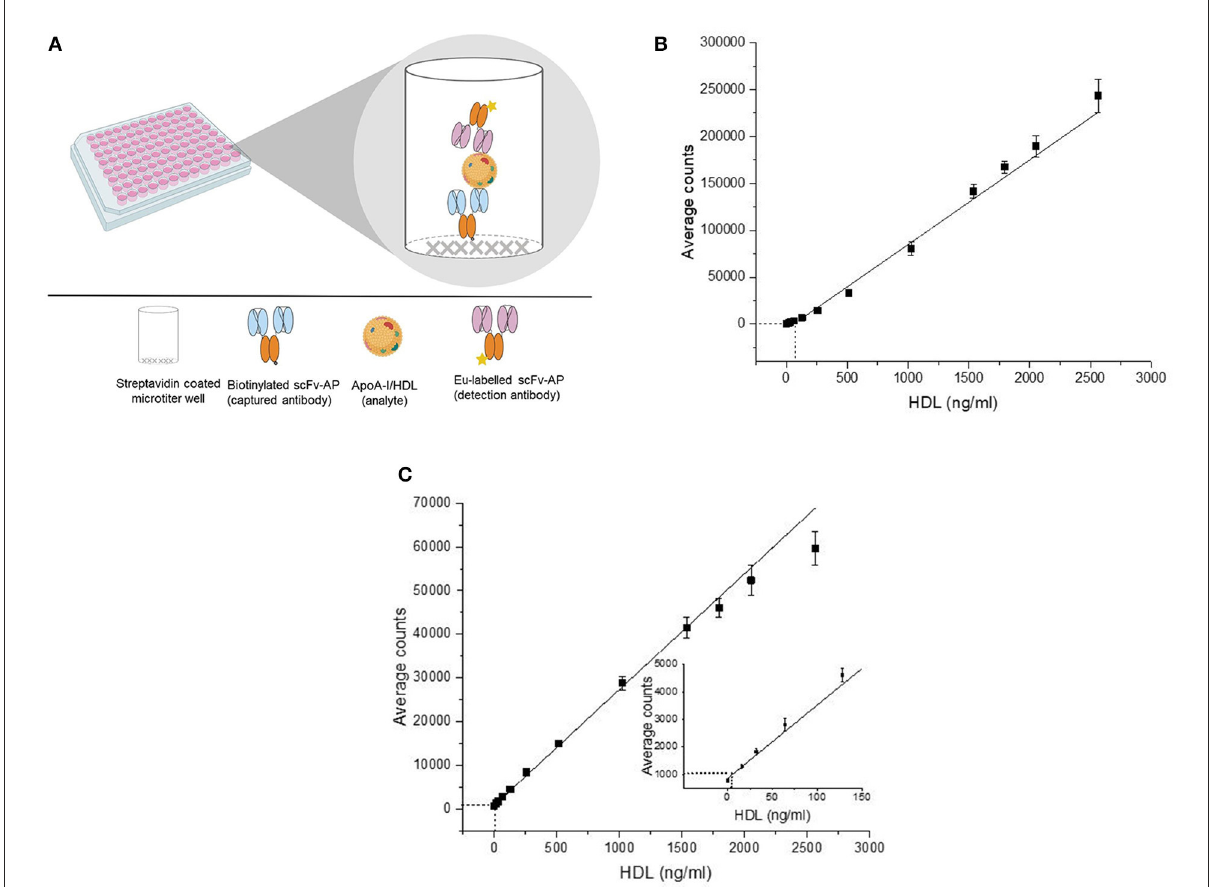
FIGURE2 Schematic representation of the principle of the direct two-site apoA-I immunoassay (A) and their standard curve (B,C) . The detection of the direct two-site apoA-I immunoassays is based on time-resolved fluorescence of europium attached to single-chain variable fragment-alkaline phosphatase fusion protein (scFv-AP) (A) . In the standard curve (B,C) , the X-axis represents the concentration of the standard (HDL) and the Y-axis represents the average of the counts obtained from the replicates of the standard. The error bars represent the standard deviation (SD) of the average counts. The curve was fitted with a linear fitting function. The analytical sensitivity (background + 5*SD) of the assay 109–121 (63.8ng/ml) (B) and assay 110–525 (6.8ng/ml) (C) is illustrated as dash-line (———). ApoA-I, apolipoprotein A-I; HDL, high-density lipoprotein; Eu,